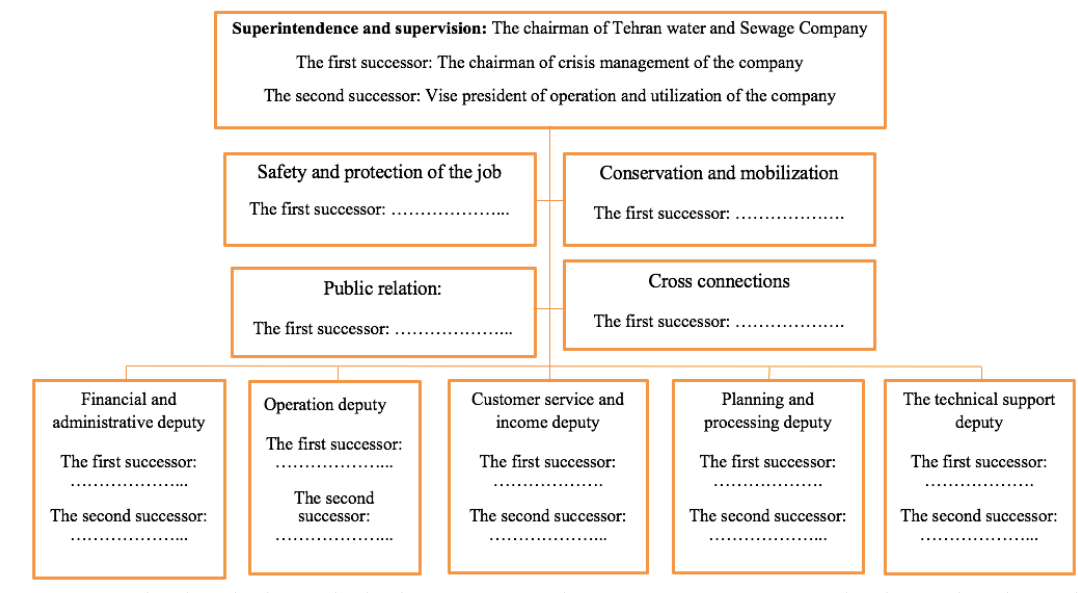
Figure 2. Organizational Chart of District 3 Water and Wastewater Company of Tehran after the accident The right answer to a crisis in an organization requires a team to lead and support response and recovery operations. Team members should be selected from experienced and trained staff who are aware of their responsibilities (Leader, 1998). The number and scope of the teams' activities can